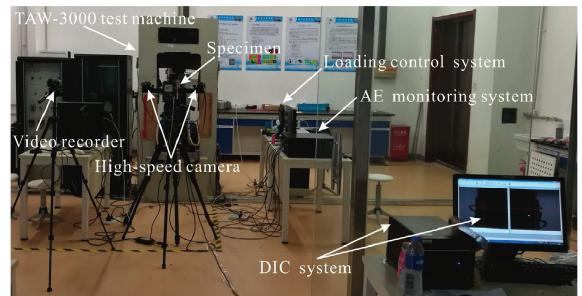
Figure 5: Experimental setup for the uniaxial compression test.